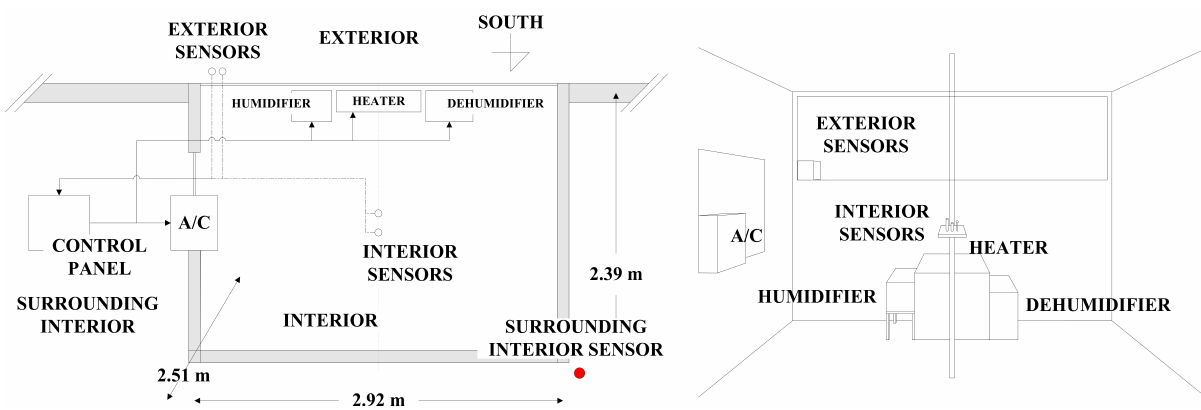
Figure 4. Layout of thermal chamber (Left: plan, Right: perspective)